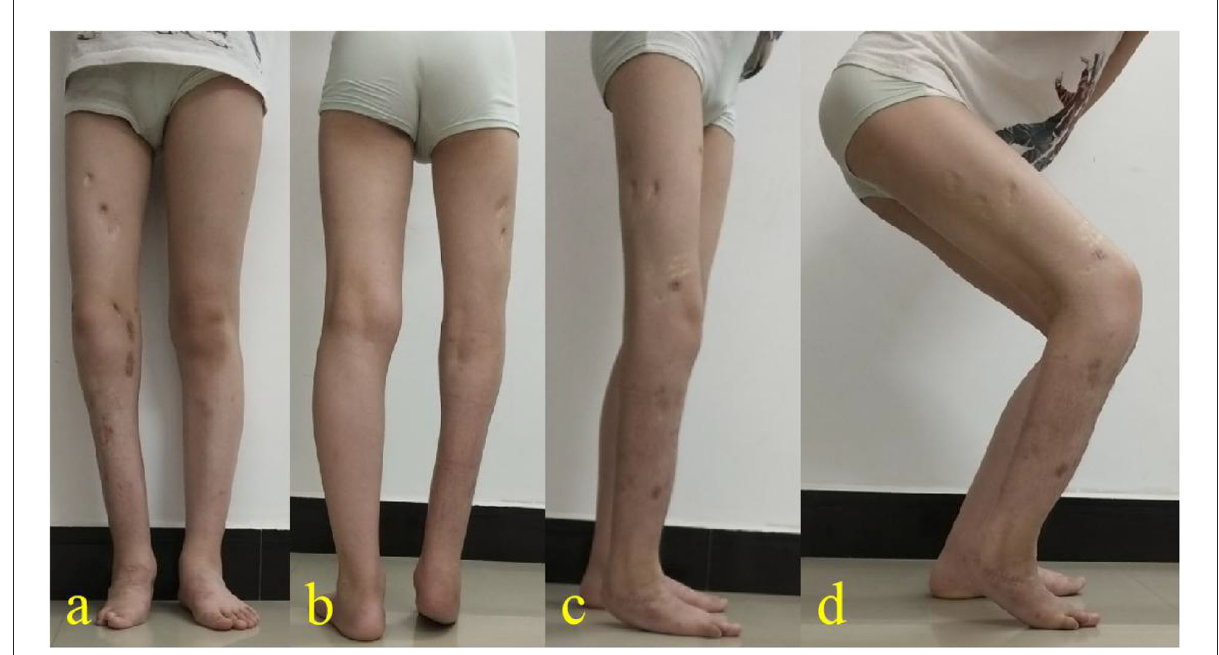
FIGURE2 Physical examination at 3.5-year postoperative follow-up. There was a 1.5cm limb length discrepancy cosmetic of his right lower extremity (a,b) . The flexion functional examination of the right knee showed moderate restriction (c,d)